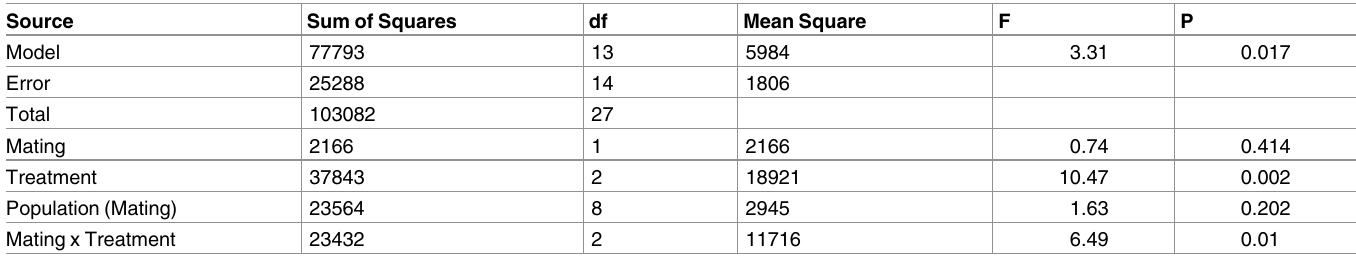
Here, we assessed the role of increased host defense against parasites versus shifts in life his- tory as means of characterizing adaptive evolution in the obligately outcrossing and mixed mating populations. We assayed survival in the presence of S . marcescens as a means of testing host defense, while we measured fecundity in the absence of the parasite to test for shifts in life history. Importantly, we conducted fecundity assays in the absence of the parasite, because parasite-induced fecundity is a form of host defense and we sought to assess general changes in host life history. Regardless of the host mating system, we found that host populations Table 3. ANOVA table for mean lifetime